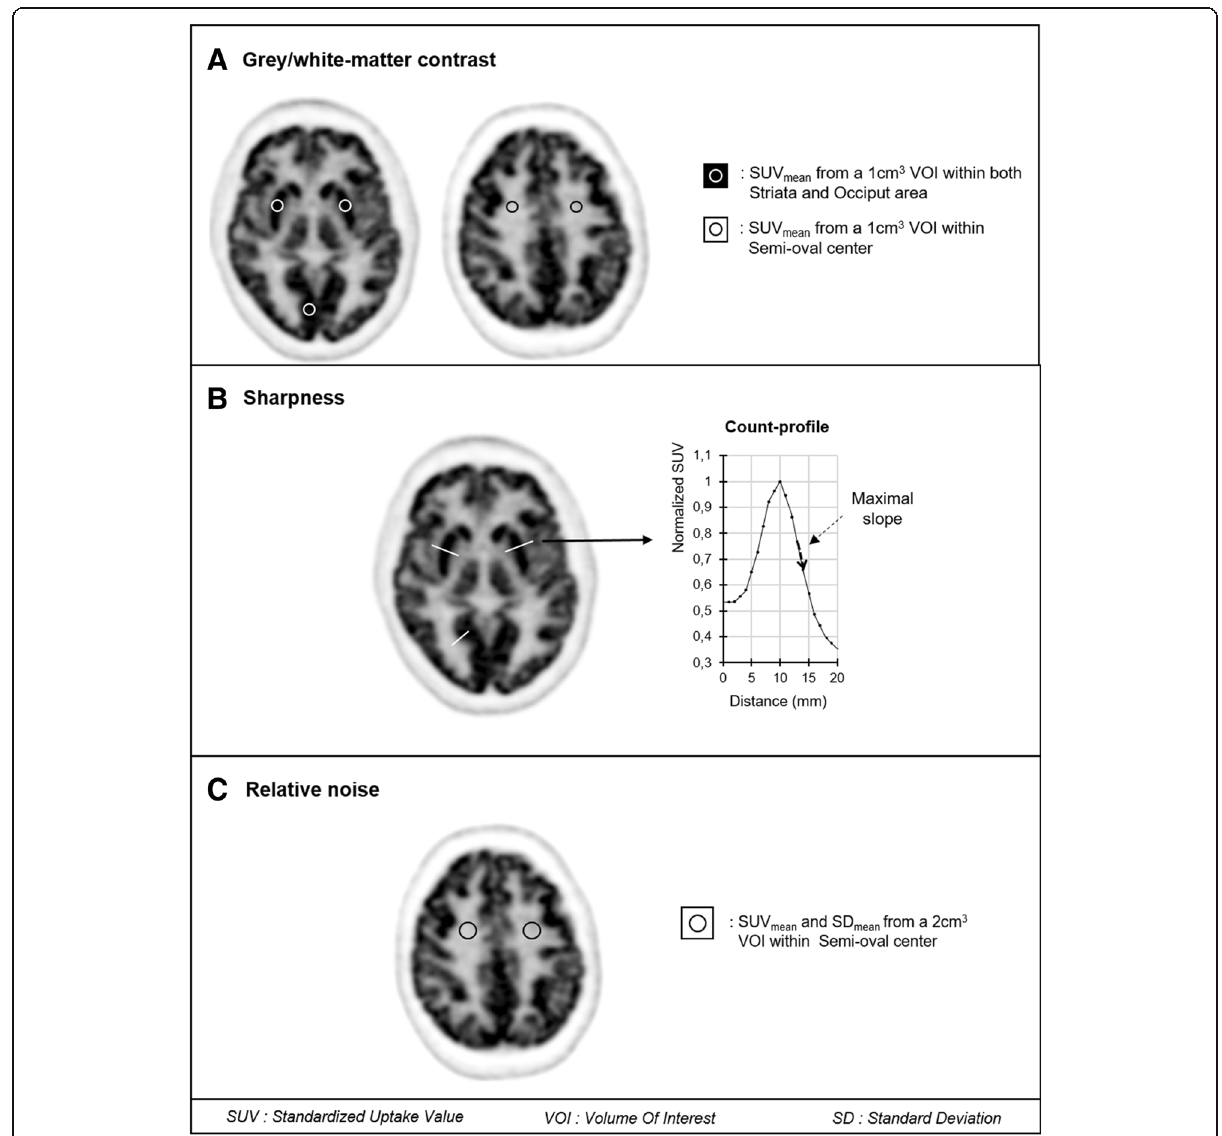
Fig. 2 Schematic representations of methods used on axial 18 F-FDG brain PET images to a quantify the contrast between central (striata) or peripheral (occiput) gray-matter structures and a white matter structure (semi-oval center), b determine the sharpness index through the maximal slope of count profiles obtained perpendicularly to the gray/white-matter interfaces of striata and occiput and further normalized to the maximal curve value, and c quantify the noise level within the semi-oval